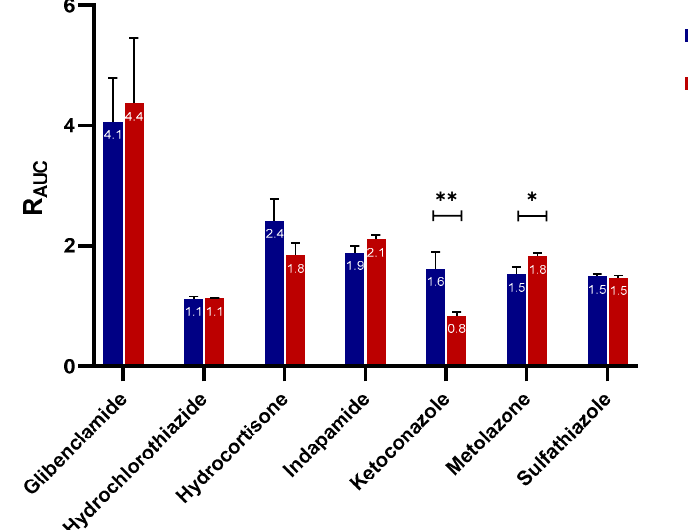
Figure 3. The area under the curve (AUC) ratio (R AUC ) of the fresh and aged and / or crystallized spray-dried APIs at tenfold supersaturation ratios. The freshly spray-dried samples are represented as SD T 0 , whereas the crystallized and / or aged samples are denoted SD T n since each of the APIs crystallized at di ff erent time points (see Table 1). At a 95% confidence interval, a p -value of < 0.05 is considered statistically significant. The mean ± standard deviation values of three replicates are shown. Here, p < 0.05 and p < 0.01 are denoted with * and **,